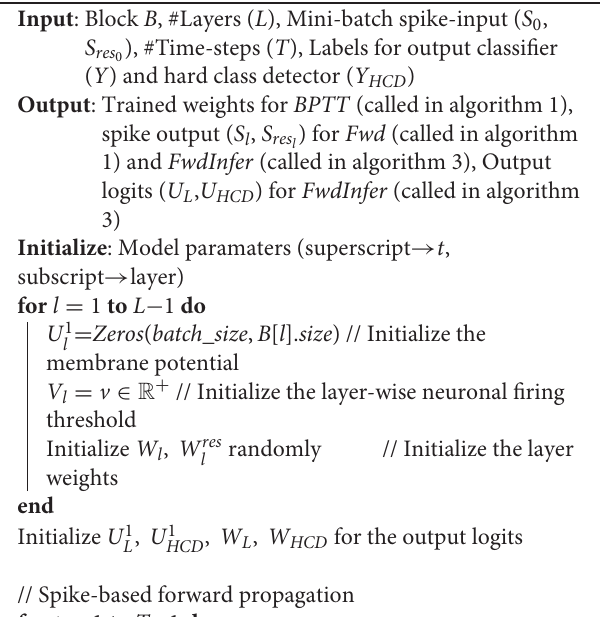
Algorithm 2: Mini-batch (with batch _ size ) spike-based backpropagation through time